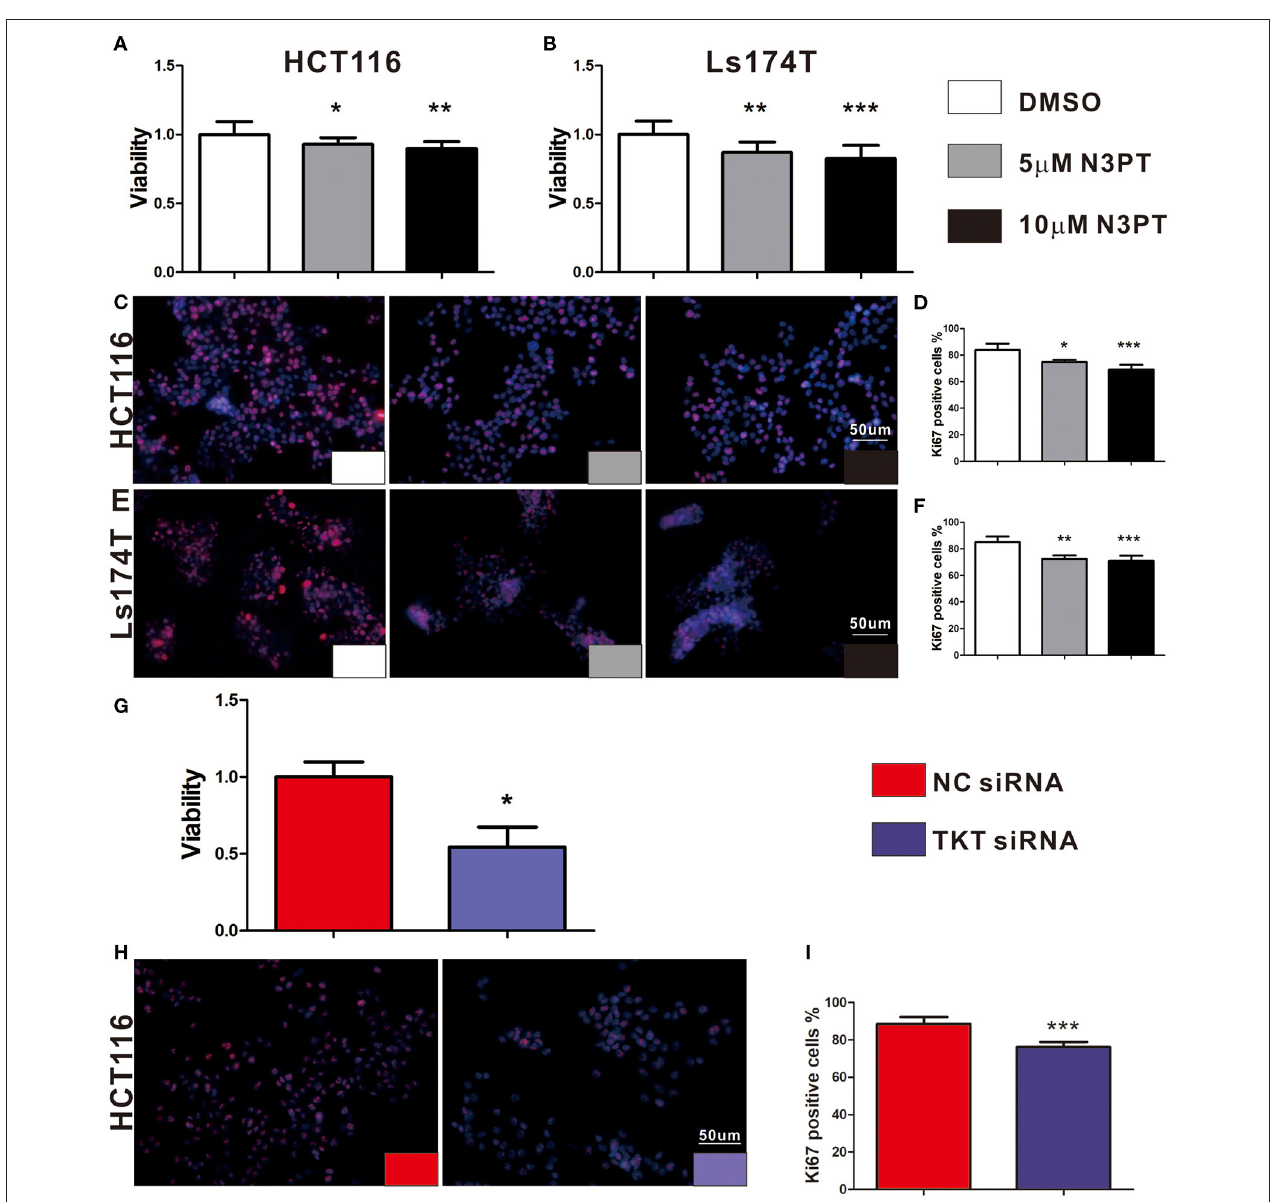
FIGURE 4 | Inhibition of TKT reduces cell viability and proliferation. (A–F) HCT116 or Ls174T cells were treated with DMSO or the TKT inhibitor N3PT (5 or 10 µ M) for 24h. (A,B) Cell viability was quantified by CCK8 assay. The viability of HCT116 cells (A) and Ls174T cells (B) was reduced after treatment with 5 µ M and 10 µ M N3PT respectively. (B–F) Cell proliferation was determined by IF of Ki67 and quantified by Ki67 positive cells in each field. Fewer Ki-67-positive HCT116 cells (C,D) and Ls174T cells (E,F) were detected after N3PT treatment. (G–I) HCT116 cells were transfected with TKT siRNA or negative control (NC siRNA) for 72h. (G) Cell viability was quantified by CCK8 assay. The viability of HCT116 cells was decreased after transfection with TKT siRNA. (H,I) Cell proliferation was determined by IF of Ki67 and quantified by Ki67 positive cells in each field. Fewer Ki-67-positive HCT116 cells were detected after transfection with TKT siRNA. N = 3/group, * P < 0.05, ** P < 0.01, *** P < 0.001 vs. the control